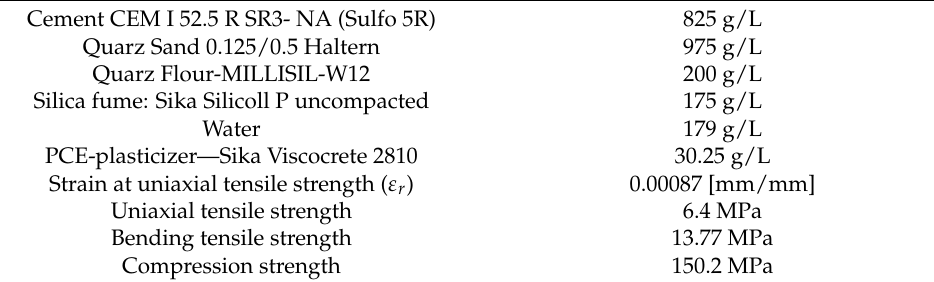
Table 1. Constituents (given in grams per litre), bending tensile strength and compression strength of the UHPC-mixture used in the